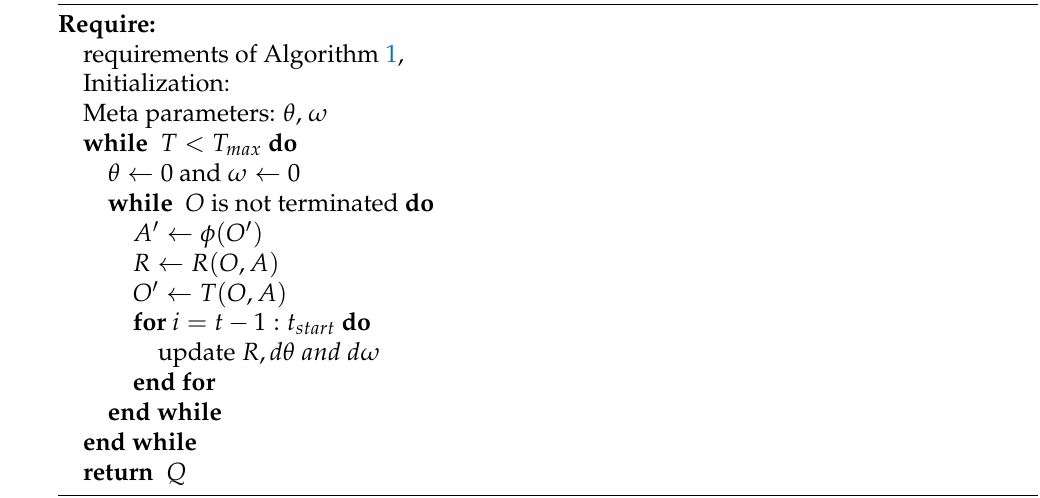
Algorithm 2 Asynchronous Advantage Actor-Critic Agents